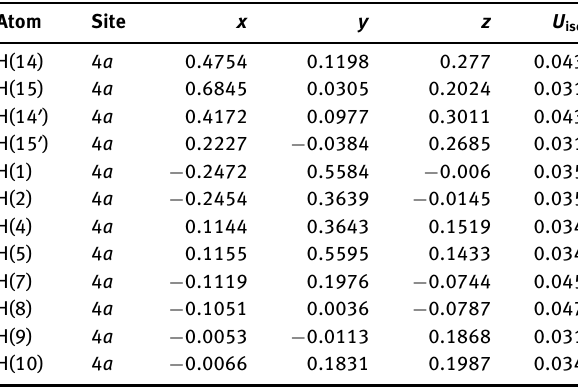
Table 2: Fractional atomic coordinates and isotropic or equivalent isotropic displacement parameters (Å 2